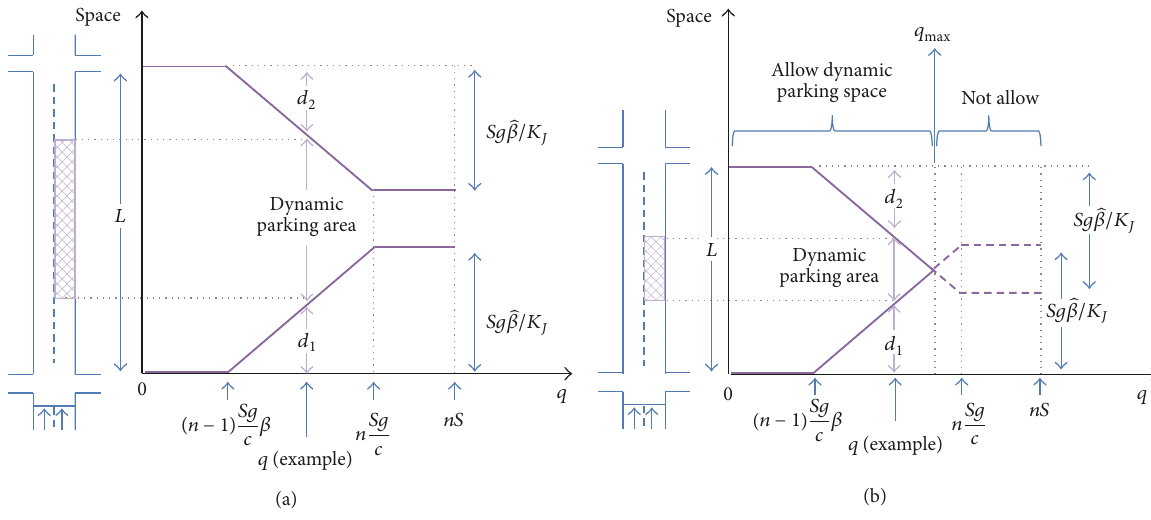
̂ 𝛽/𝐾 𝐿 < 2𝑆𝑔 ̂ 𝛽/𝐾 𝐽 . (b) If 𝐽